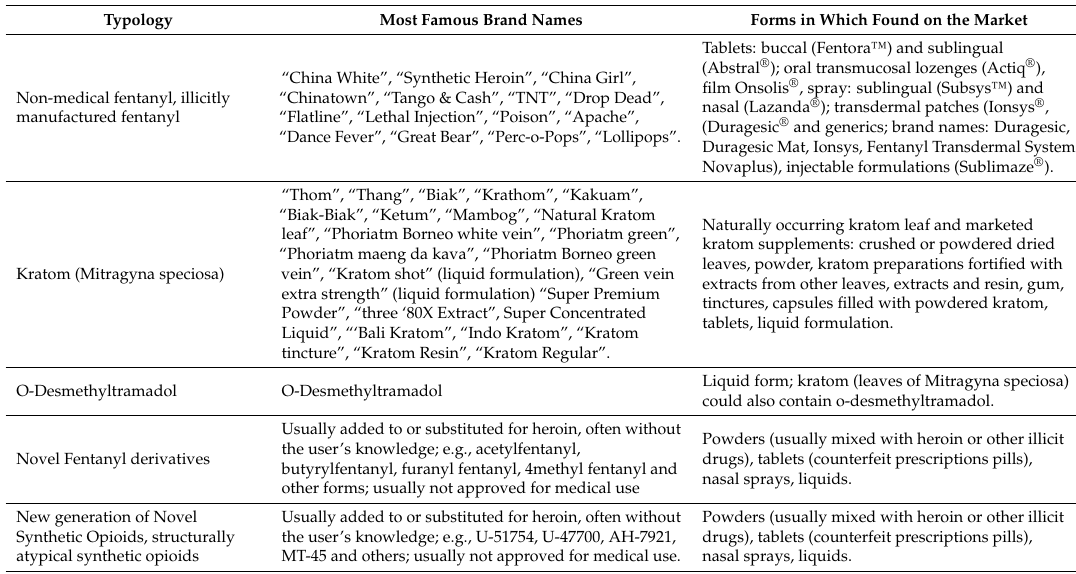
Table 1. Common characteristics of novel synthetic opioids NSOs: most famous brand (street) names, forms in which they appear on the market, means of use, neurobiology, and intentionality of use. Typology